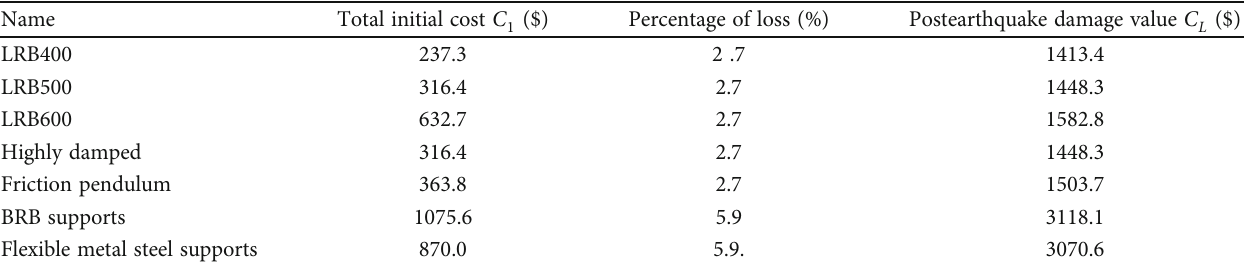
Table 8: Postearthquake loss of each structure.